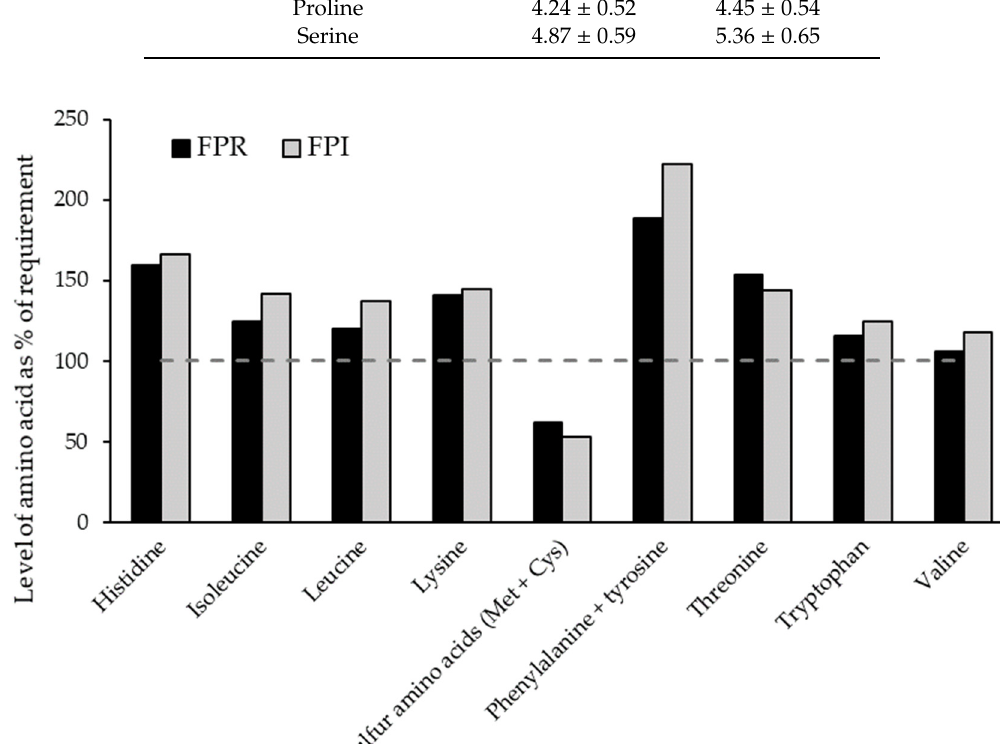
Figure 10. Levels of indispensable / conditionally indispensable amino acids in FPR and FPI, as a percentage of the World Health Organization (2007) adult requirement for each amino acid [65] .